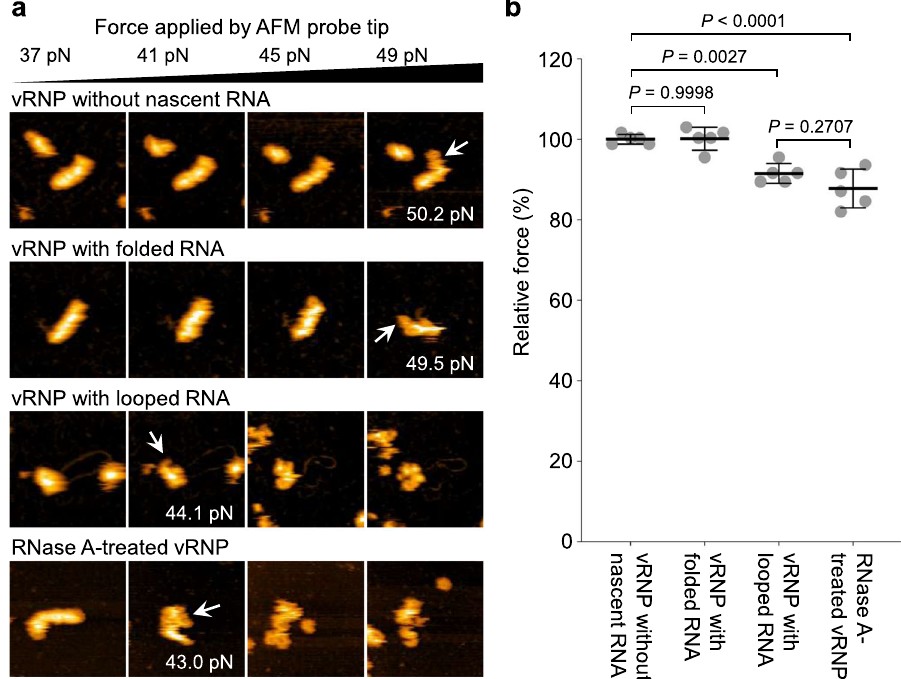
Fig. 6 Deformation of vRNP by releasing the residential vRNA. a Deformation of vRNPs with the AFM probe tip. vRNP without a nascent RNA, with a folded RNA or with a looped RNA was deformed by applying force with the cantilever tip during the HS-AFM observation. As a control for the vRNP lacking its intact vRNA, the vRNP pre-treated with 0.05 μ g mL − 1 of RNase A was also deformed. When the vRNP was con fi rmed as deformed (arrows), the force was measured as described in the Methods. Image sets are representative of 5 vRNPs of each sample and average forces required for deforming vRNPs are calculated. b Structural stability of vRNP during RNA synthesis. The force required for deforming the vRNP without nascent RNA was set as 100% and the relative force of each sample is shown. Signi fi cance was determined using the Tukey-Kramer multiple comparison test in R software. P < 0.05 was considered statistically signi fi cant. Error bars represent the standard deviation of fi ve independent